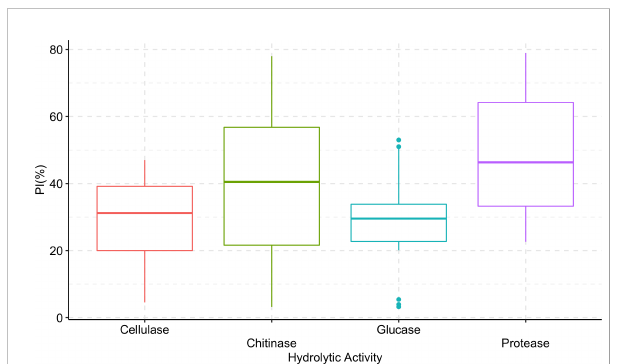
FIGURE 4 Boxplots showing the correlation between hydrolytic enzyme activity of Trichoderma isolates and percentage inhibition (PI) of F. xylarioides mycelial growth. The boundaries of the boxplots indicate the 25 th and 75 th percentiles, and the solid lines within the boxes indicate the median value. PI, Percentage of